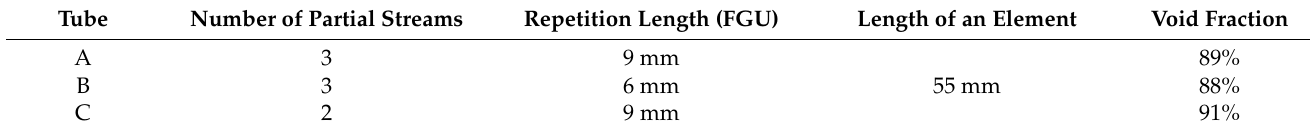
Table 2. Geometry parameters of the different FGE types.